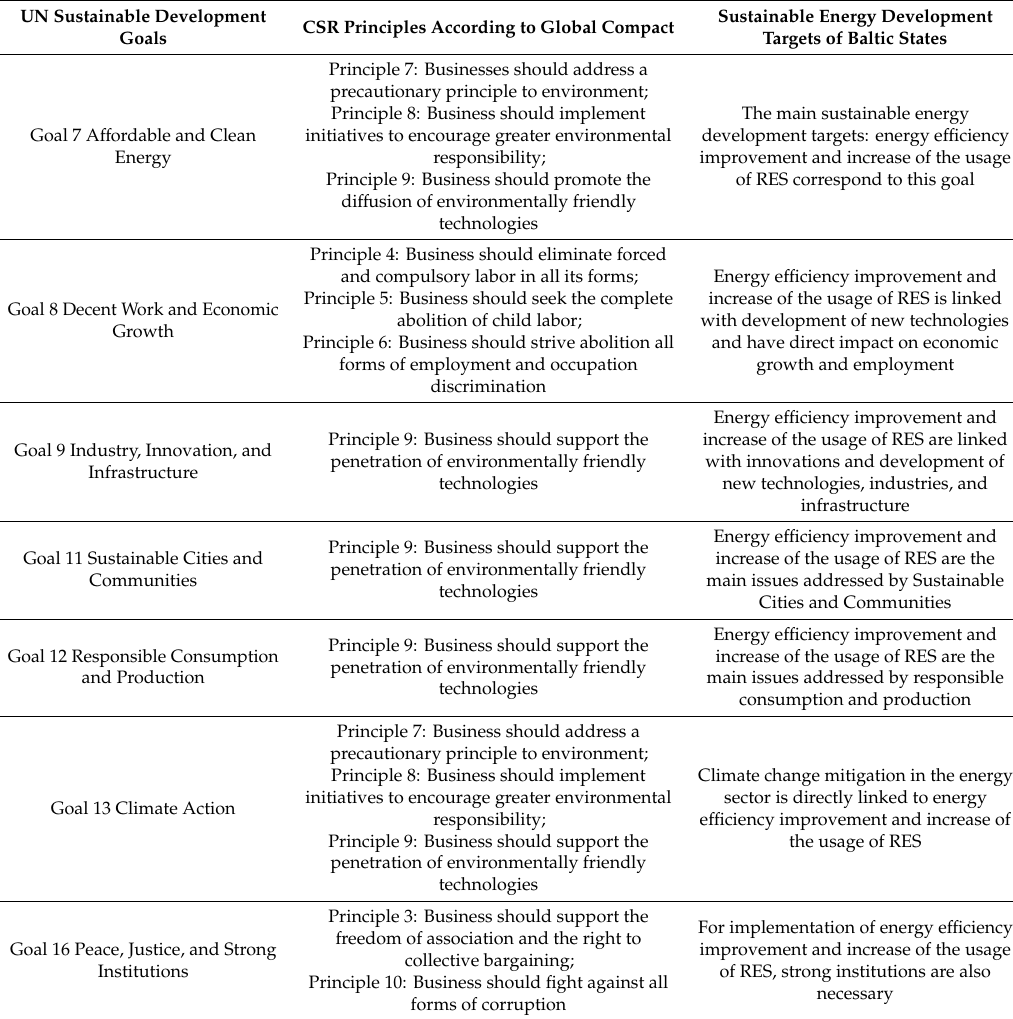
Table 5. Sustainable development goals, CSR principles, and sustainable energy development targets in Baltic States. Source: created by authors based on